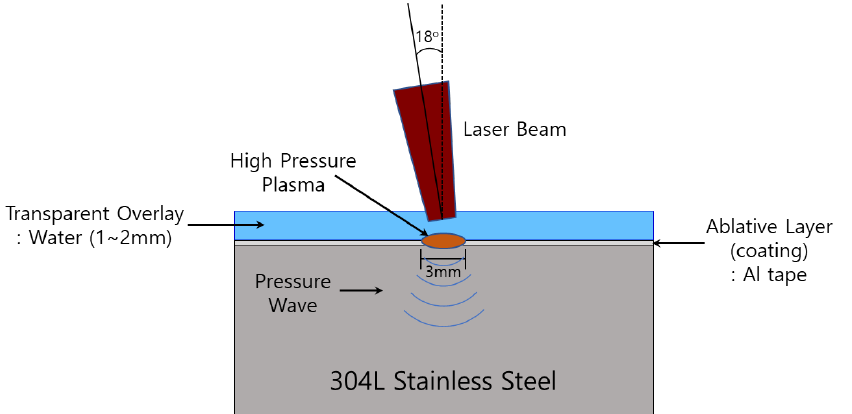
Figure 2. Schematic of laser peening process. Table 4. Conditions of laser peening treatment.